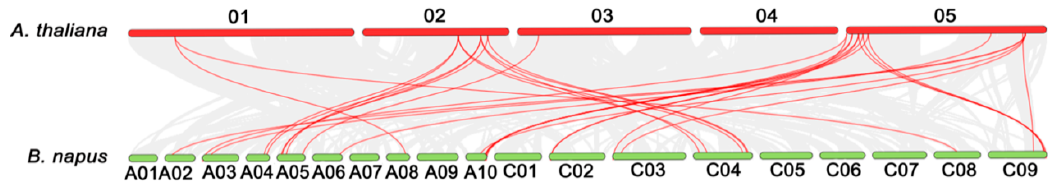
Figure 2. Synteny analysis of LACs between A. thaliana and B. napus . Gray lines in the background indicate all the collinear blocks, red lines highlight the syntenic LAC gene pairs. The figure was constructed by TBtools 0.66444553 (https://github.com/CJ-Chen/TBtools).